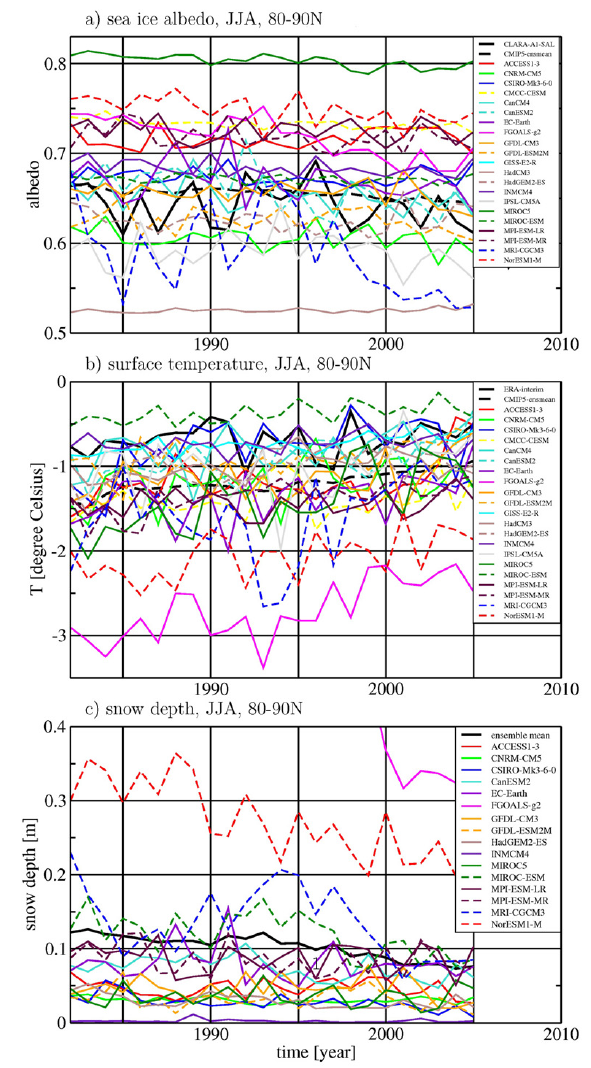
Fig. 8. (a) Summer-averaged (JJA) ice albedo in the central Arctic, averaged over 80–90 ◦ N for 1982–2005. (b) The same as (a) but for surface temperature. (c) The same as (a) but for snow depth on ice.